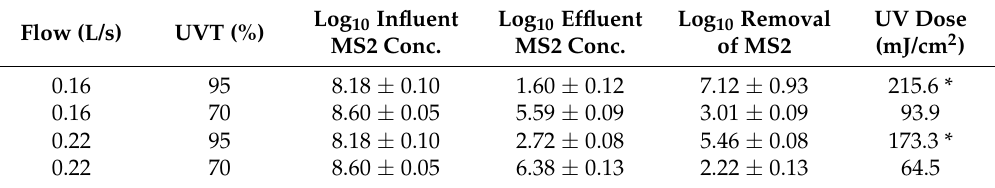
Table 3. UV dose for the system at various flow rates and UV transmittance (UVT) values. Log 10 Influent Log 10 Effluent Flow (L/s) UVT (%) MS2 Conc. MS2